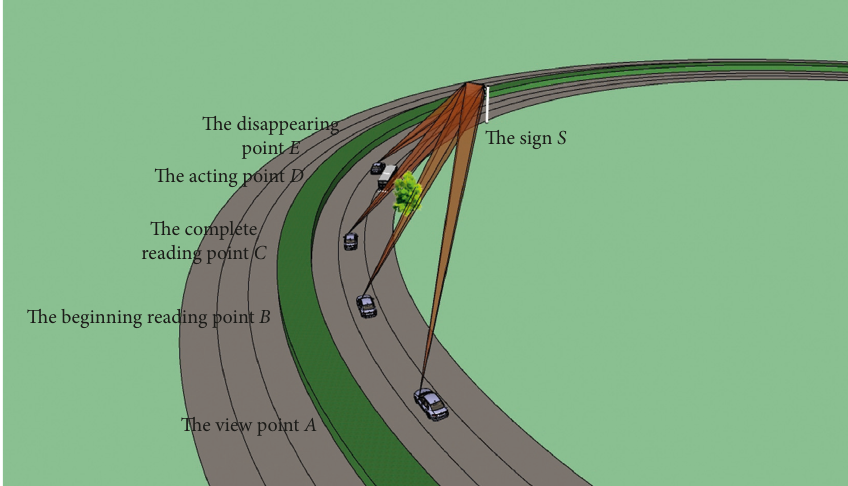
Figure 7: Simulation diagram of the affected visibility window at the inner curve. (for details, refer to the text).